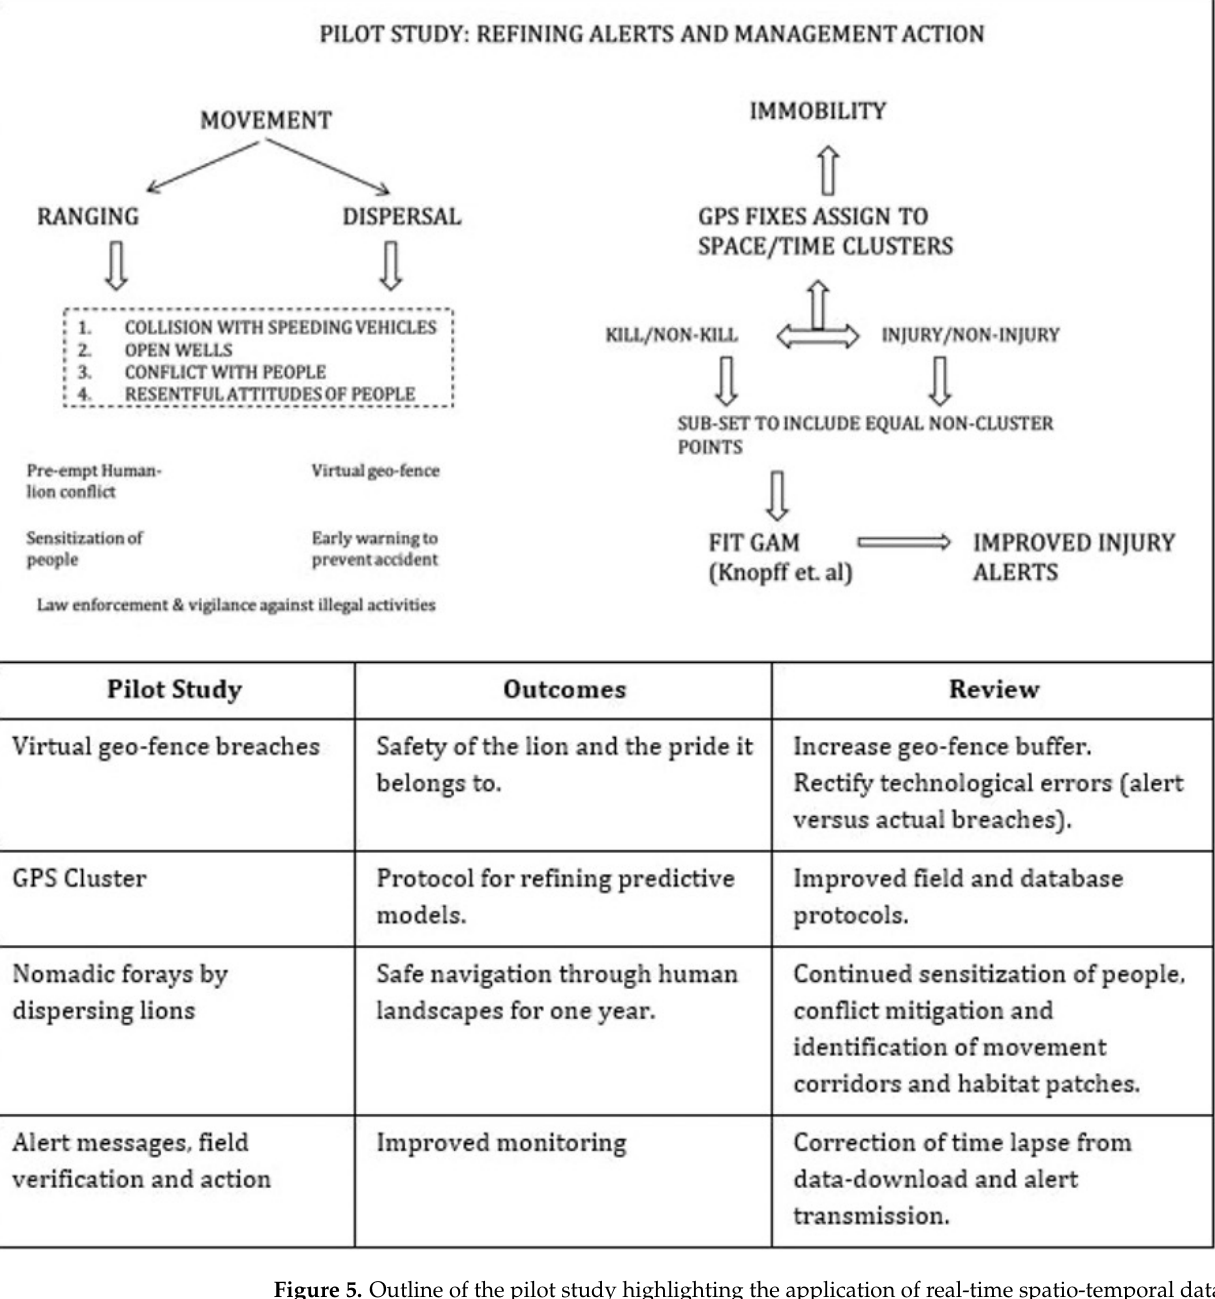
Figure 5. Outline of the pilot study highlighting the application of real-time spatio-temporal data for management action to conserve endangered Asiatic lions.